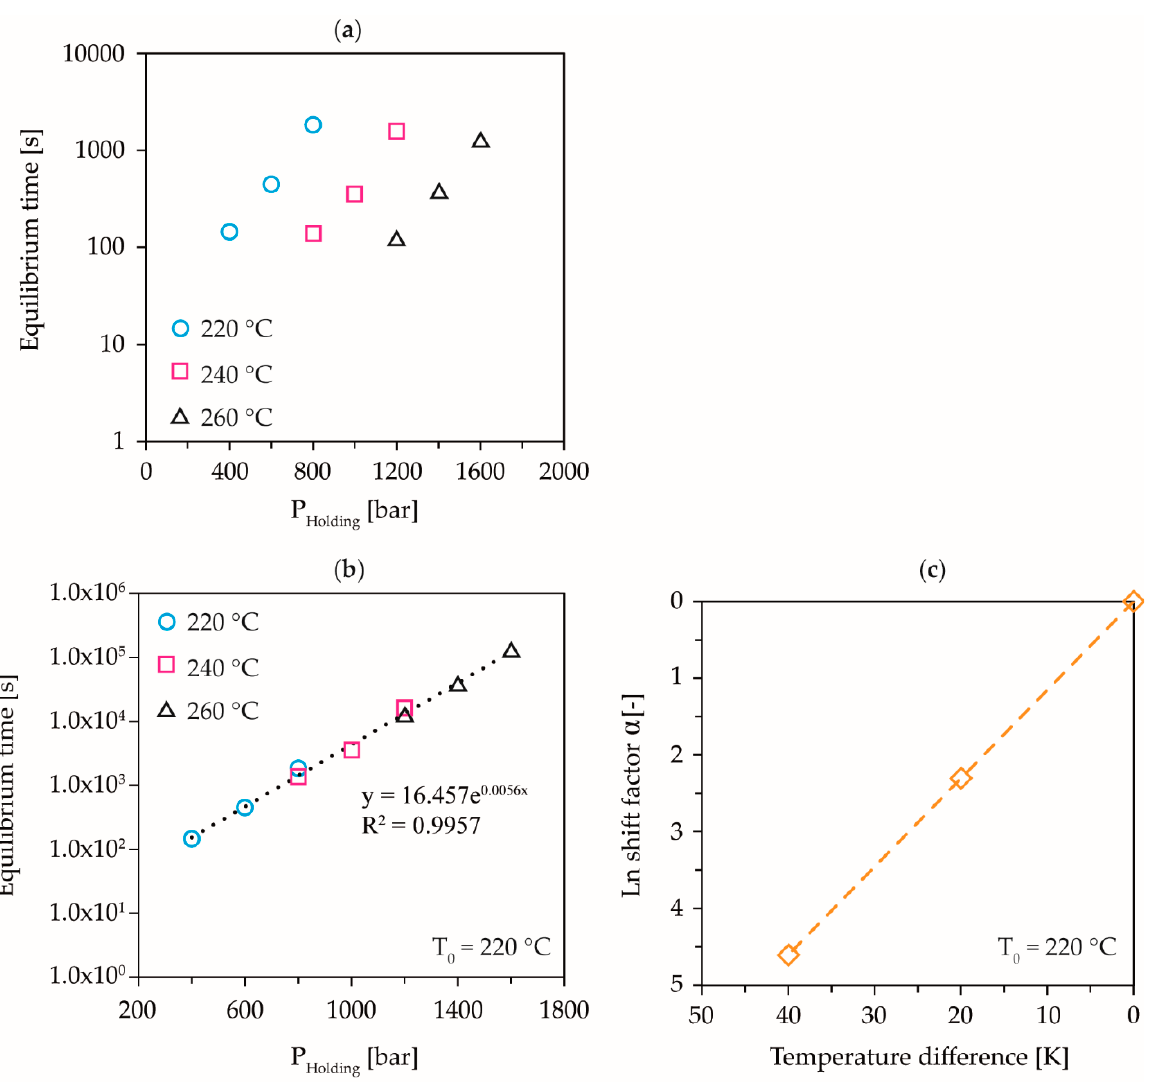
Figure 10. Construction of the master curve to calculate the equilibrium time, as a function of the holding pressure and the temperature at a compression rate of 1.0 × 10 − 3 ; logarithmic plot of the measured equilibrium times ( a ), shift of the measured equilibrium times to a master curve at 220 °C and 1.0 × 10 − 3 ( b ), and temperature shift factors ( c ).